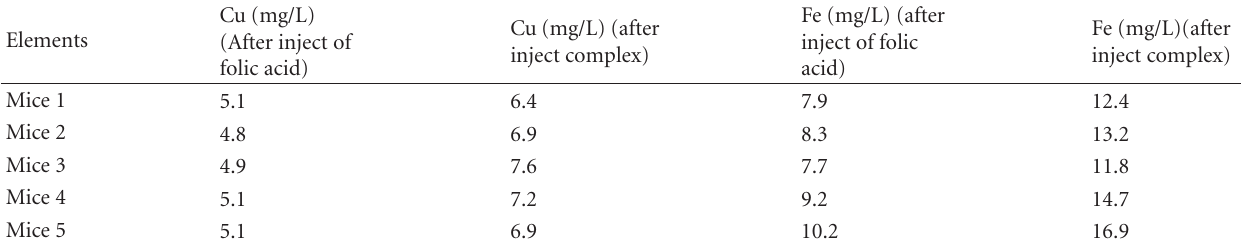
Table 4: The concentration of Cu and Fe elements in mice blood serum in case of folic acid and folic acid metal complex. Elements